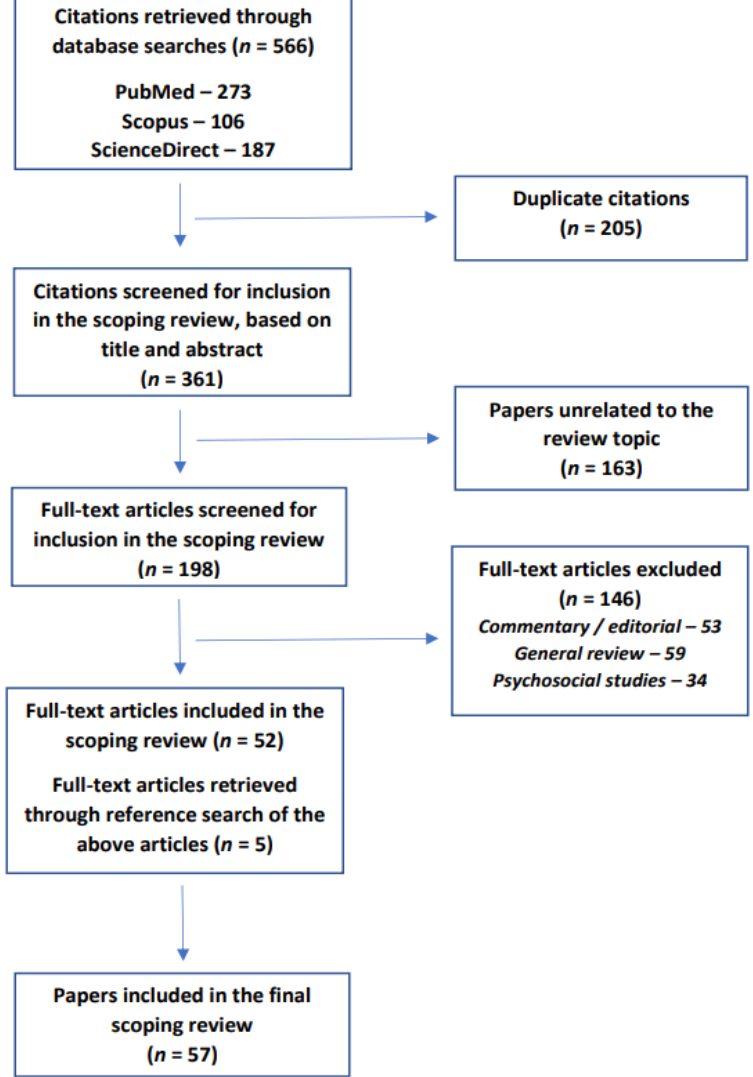
Figure 2. PRISMA-ScR flow diagram depicting the selection of articles for inclusion in this